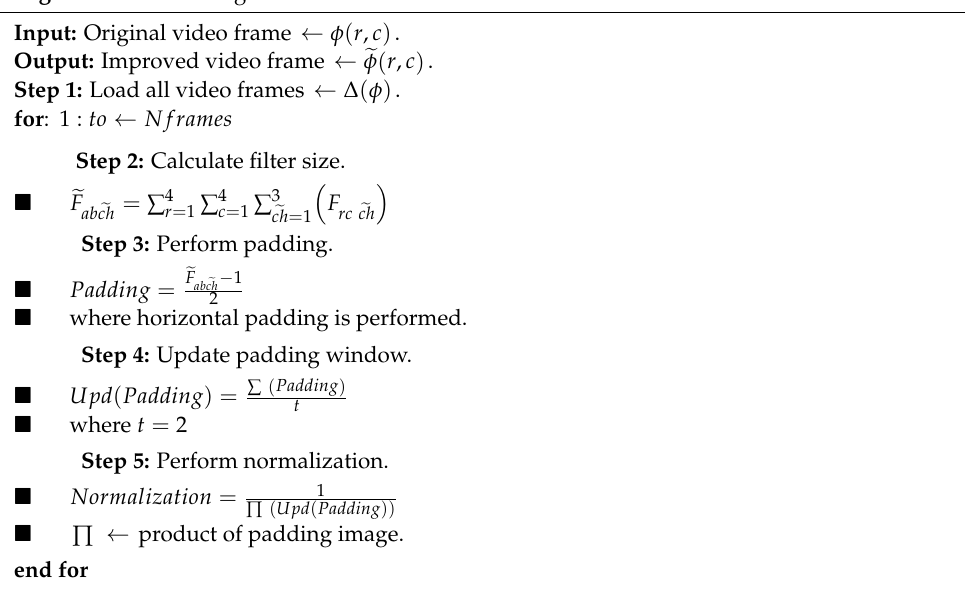
Algorithm 1: Data Augmentation